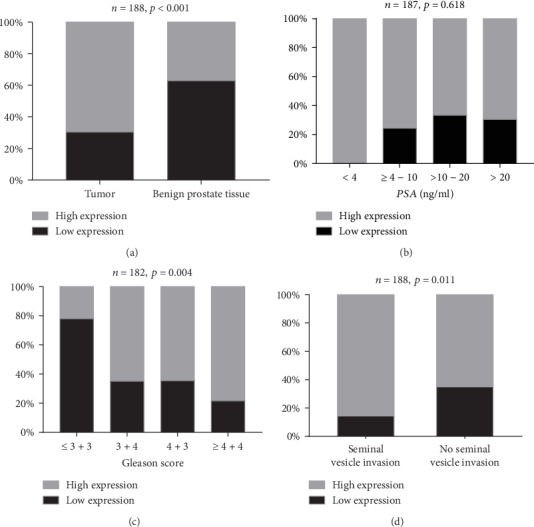
FASN expression in TMA by IHC. Comparison between tumor tissue and benign tissue (a). The relationship between FASN expression and preoperation PSA (b), Gleason score (c), and seminal vesicle invasion (d).